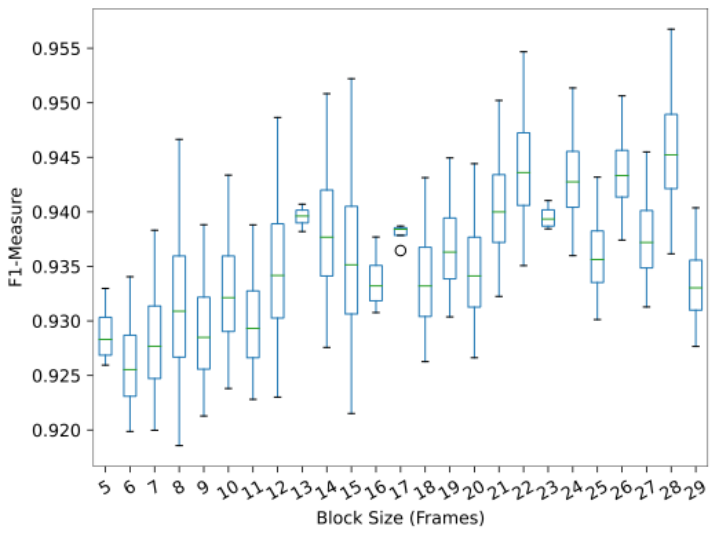
Figure 8. Performance of block sizes (5–29 frames) as input of the LRCN for the Jamendo dataset. Circles represent atypical values within the evaluation